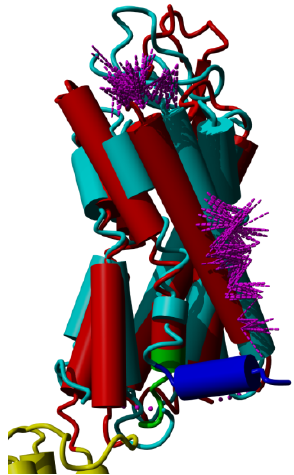
Figure 3. The structures of the neurotensin 1 (NTS1) receptor (red; PDBid = 4grv [19]) and rhodopsin (blue; PDBid = 1f88 [2]). The lysozyme that is cloned between helices V and VI in NTS1 is partly shown (in yellow). Helix VIII is shown in dark blue in rhodopsin and in green in NTS1. The purple lines indicate crystal packing contacts made by helix I in